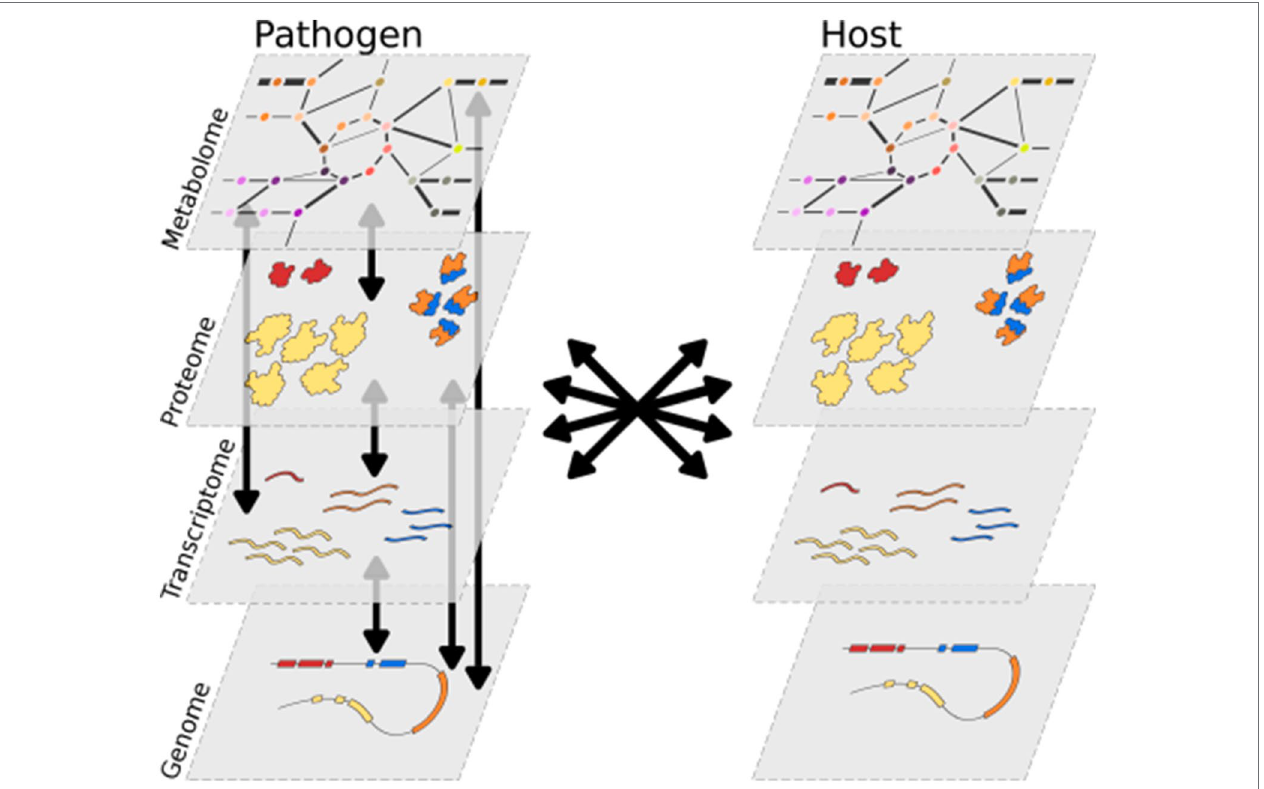
FIGURE 1 | The molecular layers of a cell are all interconnected and form a complex and integrated system. In the symbiosis between a pathogen and a host, their systems are connected, and interactions occur between all molecular